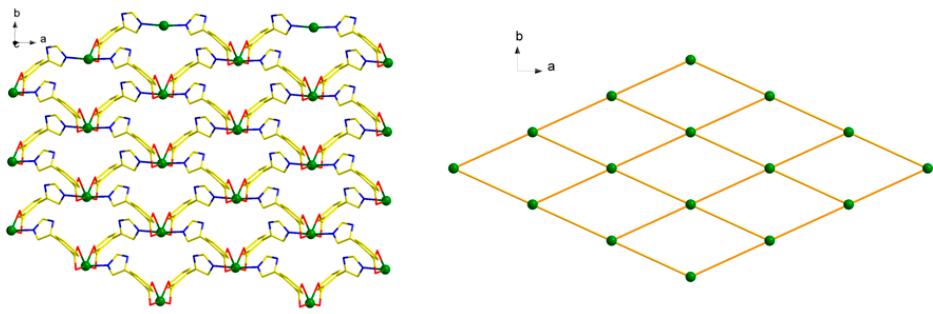
Figure 2. 2D layered structure (left) and 2D (4, 4) sql layered network of 1 (right).